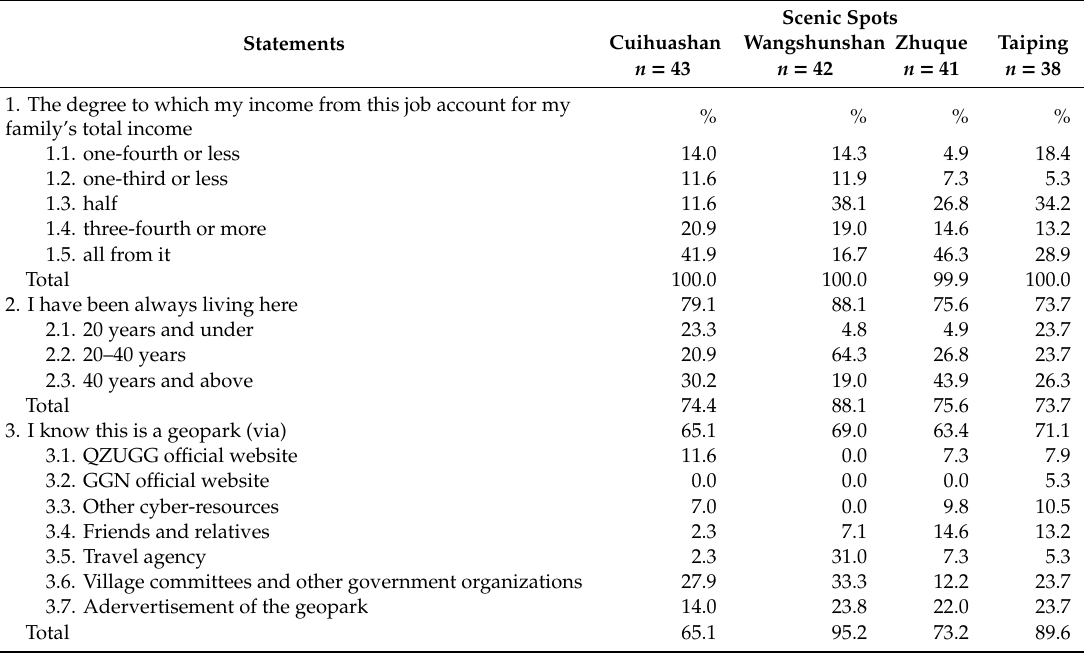
Table A3. Income and livelihood characteristics.